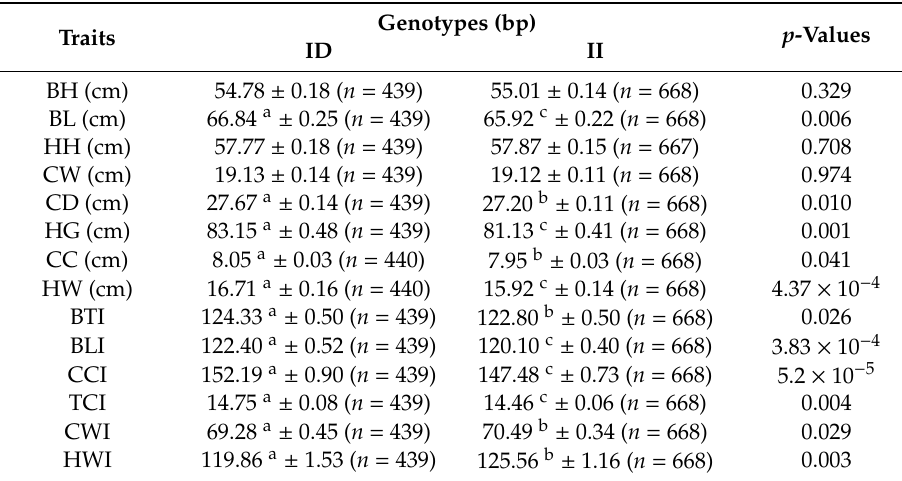
Table 3. Associations of the indel with growth traits in SBWC